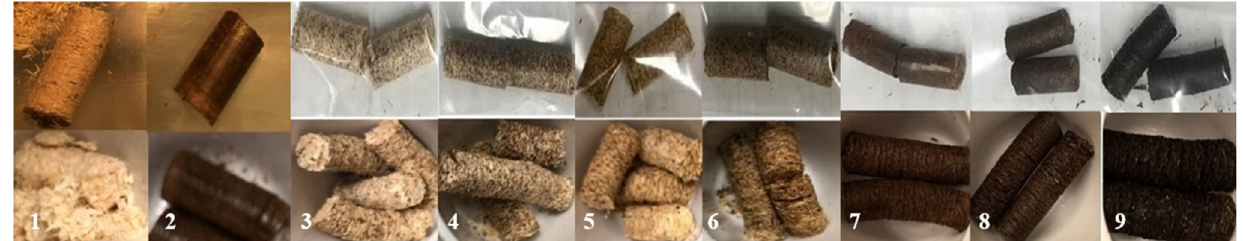
Figure 8. Illustrations of treated and non-treated pellets before ( top ) and after ( bottom ) moisture absorption test. From left to right: pellet made of raw sawdust ( 1 ), steam-treated ( 2 ), raw sawdust with 10% ( 3 ) and 20% ST ( 4 ), optimized torrefied sawdust with 10% ( 5 ) and 20% ST ( 6 ), torrefied sawdust at outside temperatures of 230 ( 7 ), 260 ( 8 ) and 290 °C ( 9 ) with 20% ST.